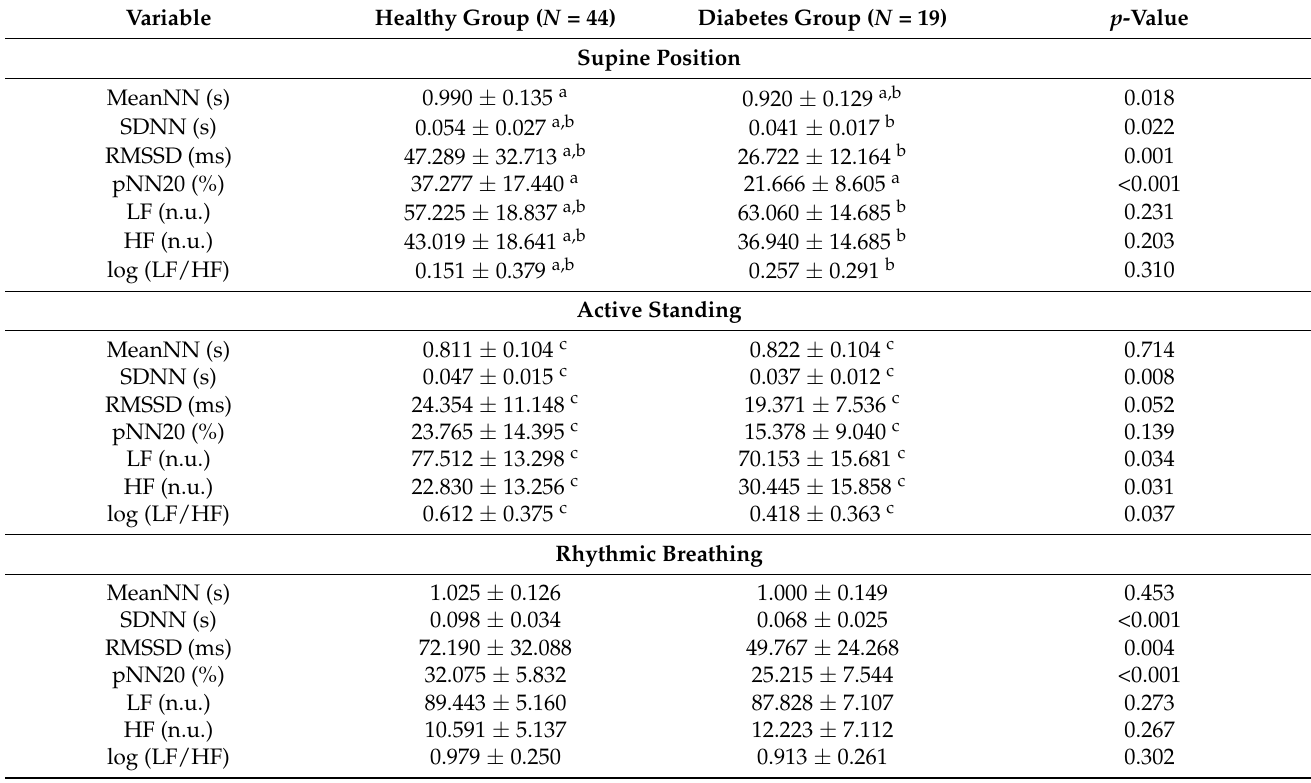
Table 3. Comparison of HRV indices between groups (healthy and diabetes, p value in the right column) and between maneuvers (supine, active standing, and rhythmic breathing) in the same group (a, b and c markers represent p -value).